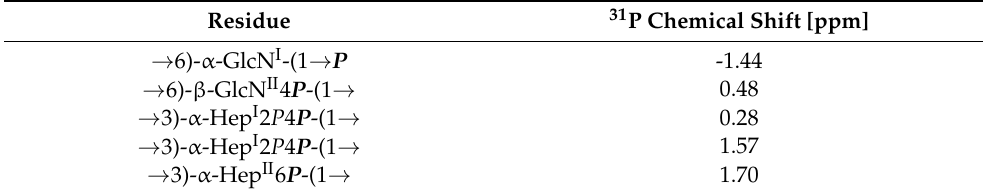
Table 5. 31 P NMR chemical shift data of 1 recorded in D 2 O at 310 K.